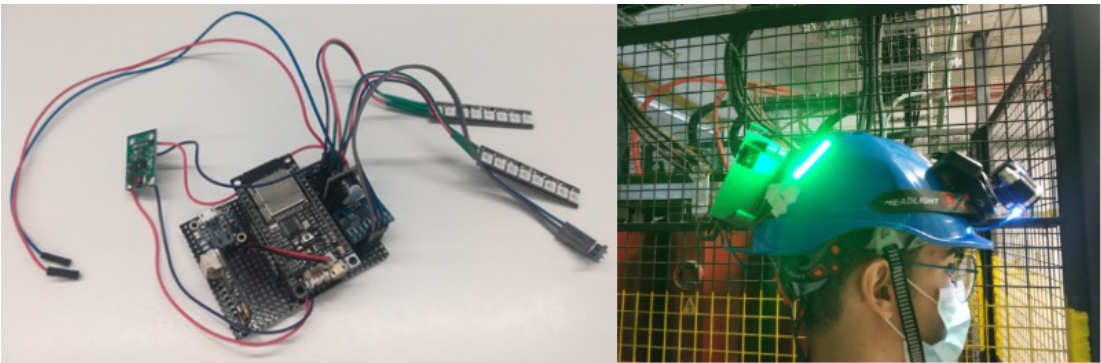
Figure 3. The electronic system of the helmet.